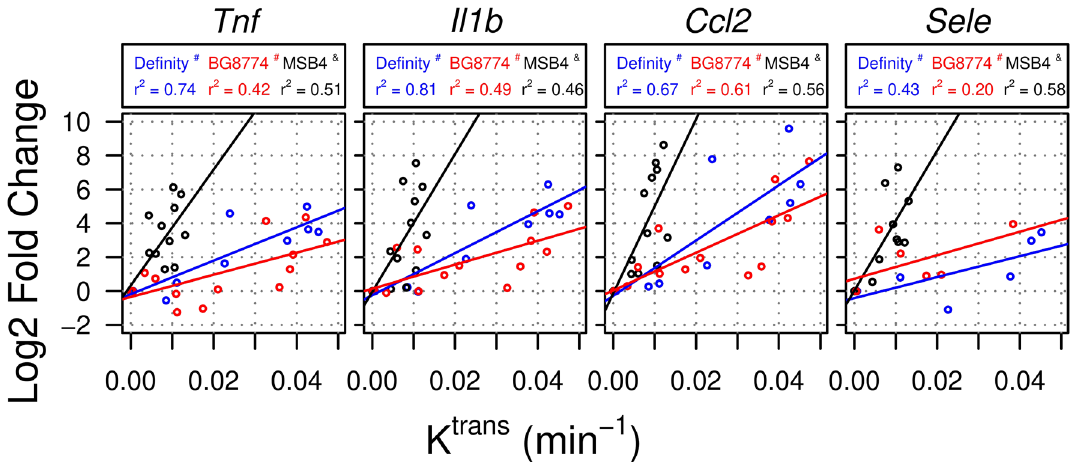
Figure 7. Relationship between K trans and relative gene expression for inflammatory mediators significantly influenced by microbubble formulation. For sonications with each microbubble formulation, significant correlations were detected between K trans and relative expression of Tnf , Il1b , Ccl2 , and Sele . These relationships were significantly different between sonications with MSB4 in circulation, compared to either Definity or BG8774. Disparate symbols (# vs &) indicates significantly different slopes (K trans vs relative gene expression) in pairwise post-hoc comparisons between microbubble